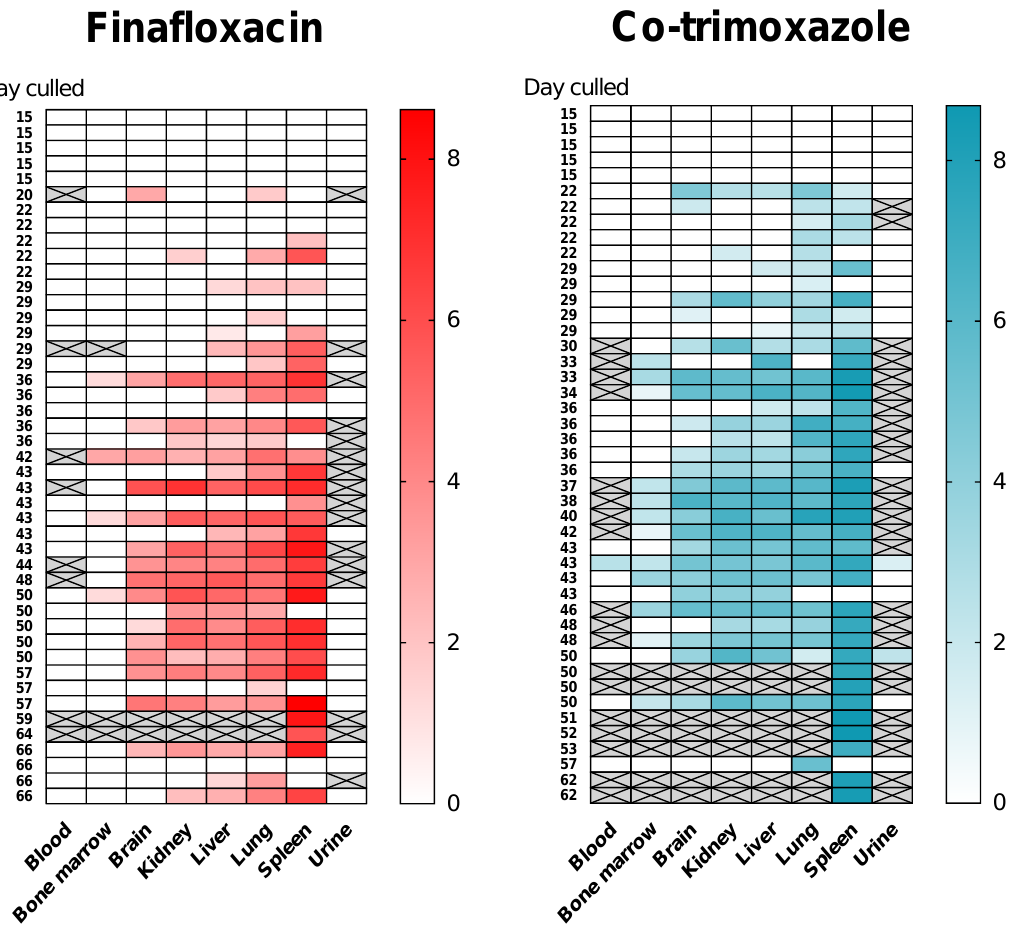
Figure 4. The bacterial burden in mice. Mice were infected with a mean retained dose of 142 CFU of B. pseudomallei by the inhalational route and treated with finafloxacin (37.5 mg/kg) every 8 h or co-trimoxazole (78 mg/kg) every 12 h, orally, for 14 days, initiated at 24 h post-challenge. A group of animals were challenged and treated with the vehicle every 8 h. A cross indicates data not collected. The data for some mice are not shown if they had reached a humane endpoint and data was not collected in its totality. Additionally it was not possible to obtain urine, blood and a single lung from all mice. It is important to note that fewer mice reached the end of the experiment when treated with co-trimoxazole and therefore less mice were available at the later time points for bacterial analysis. The colour intensity relates to the bacterial burden (CFU) transformed to the logarithm of 10 (i.e., 1 = 10 and 8 = 10 8 ). Each row is a mouse and the time of cull (in days) is given on the 𝑦 -axis. ( left ) mice treated with finafloxacin and ( right ) co-trimoxazole. No bacteria were detected in the bone marrow until day 29 post-challenge when two mice treated with co-trimoxazole were colonised. No bacteria were found in the blood